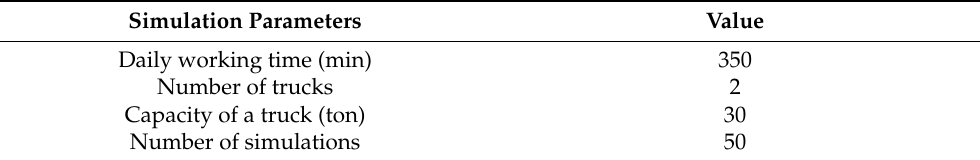
Table 3. The value of the simulation parameters used for truck haulage system